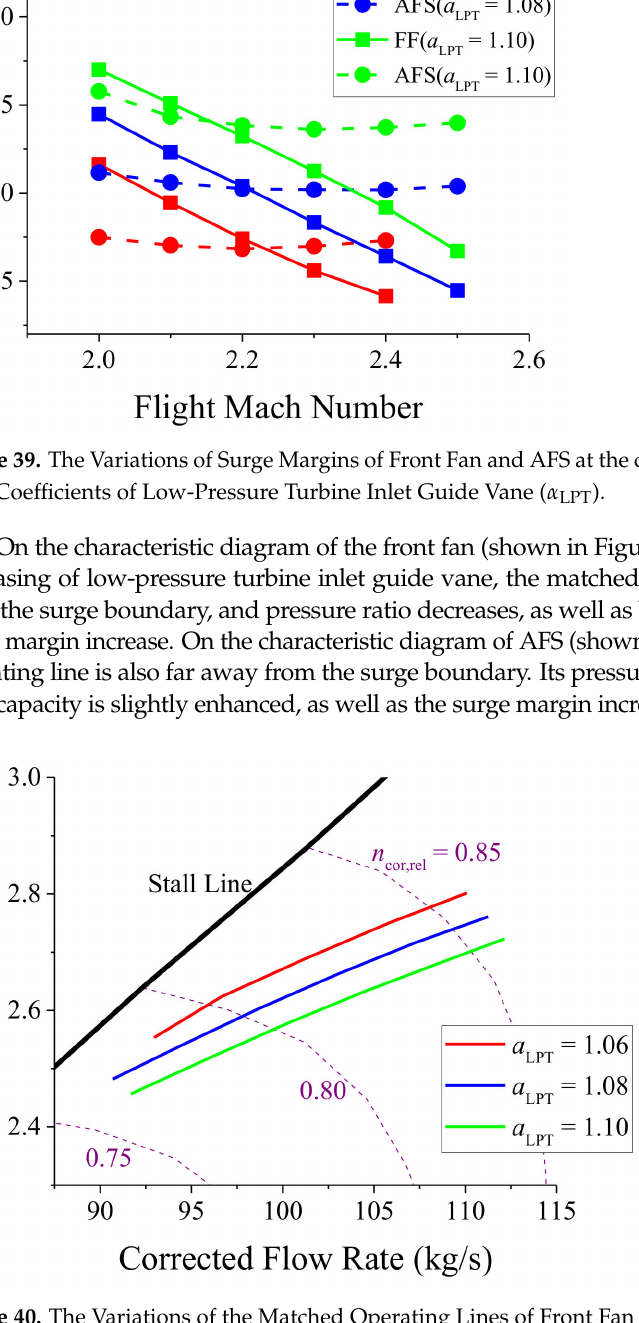
Figure 40. The Variations of the Matched Operating Lines of Front Fan at the conditions of Different Throat Area Coefficients of Low-Pressure Turbine Inlet Guide Vane ( α LPT